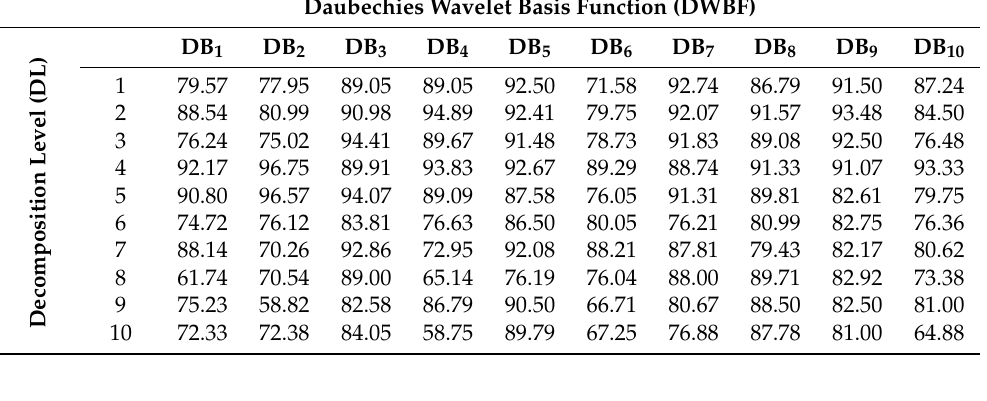
Table 5. Average accuracy (%) due to DWBF and decomposition level (DL). Table 7. Average specificity (%) due to DWBF and decomposition level (DL).